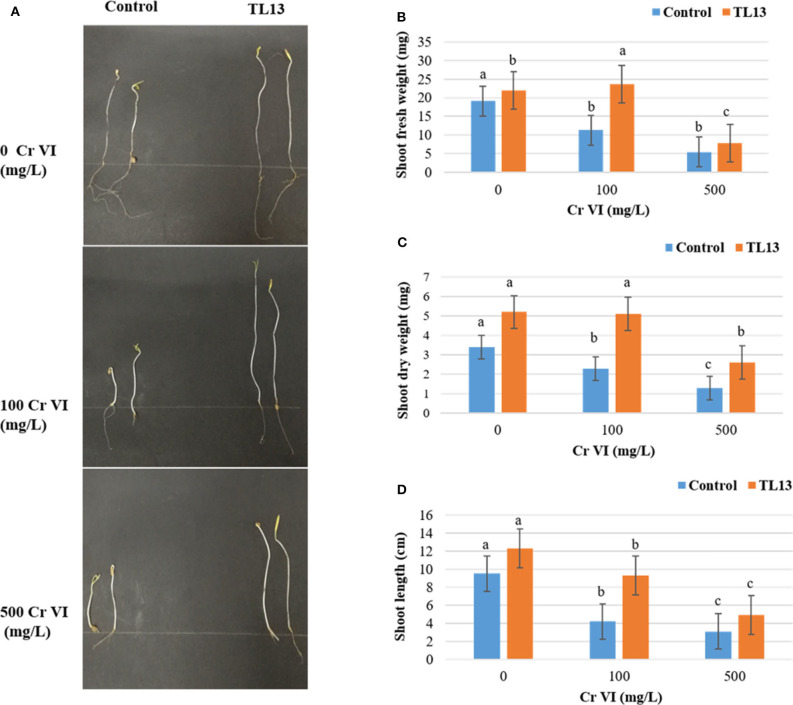
Effect of TL13 inoculation on the germination of tomato seeds under 0, 100, and 500 mg/L of Cr(VI). (A) View of the plantlets after 8 days of germination; (B) shoot fresh weight; (C) shoot dry weight; (D) shoot length. Values are means of (n = 3 per treatment); for each treatment, 20 tomato seeds were considered; error bars represent standard deviation. For each parameter, panels with different letters indicate significant differences at P <0.05 (ANOVA, Duncan post-hoc test).